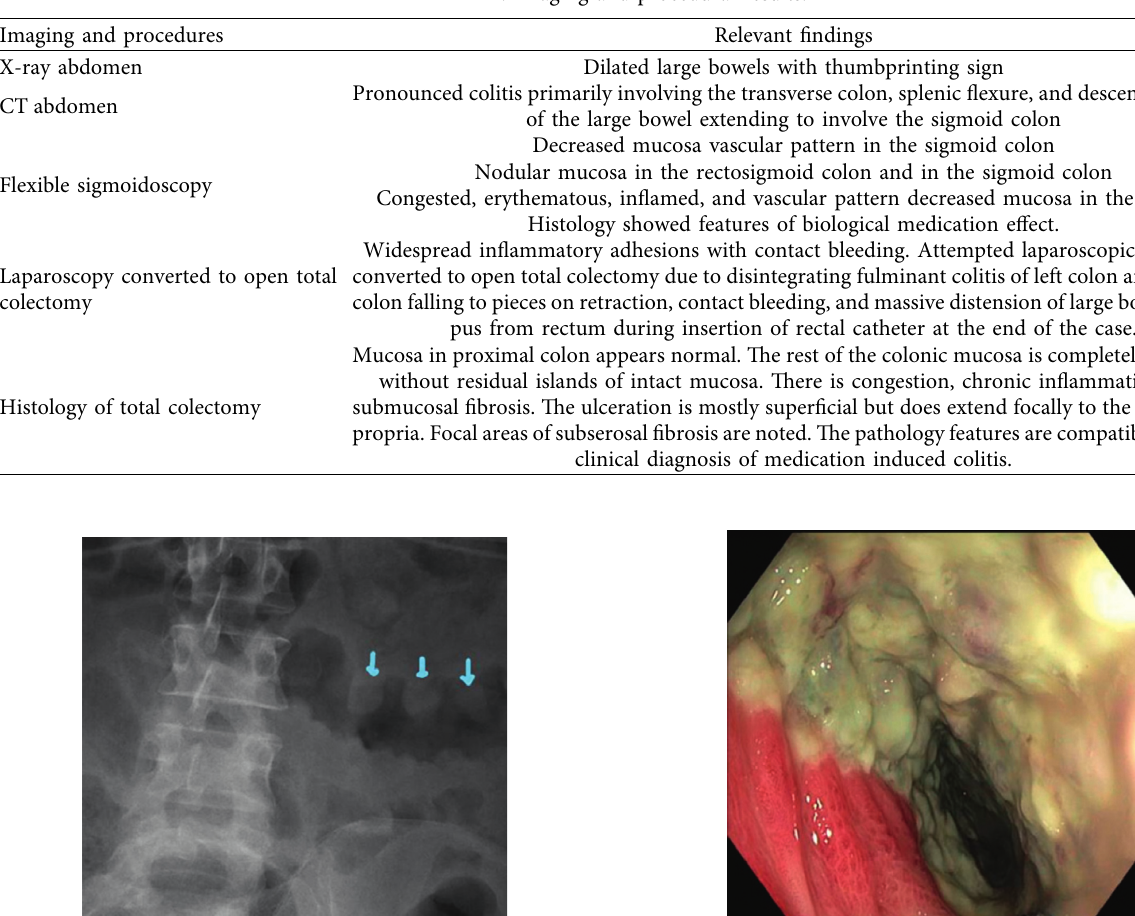
Table 2: Imaging and procedural results.